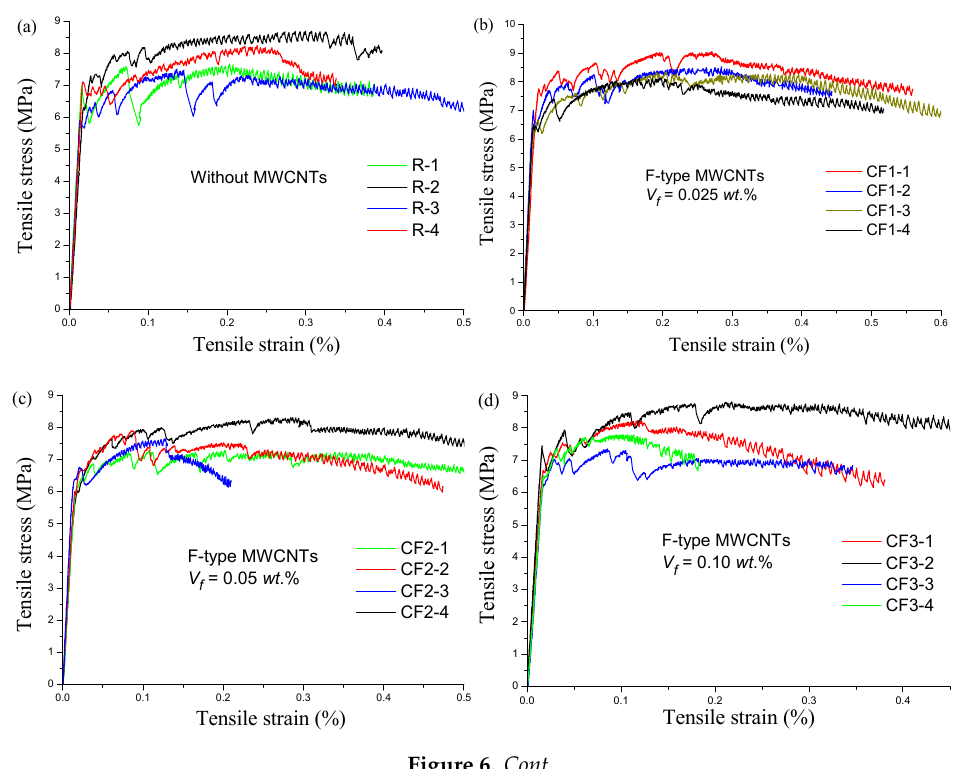
Figure 5. Direct tensile strength of each group.